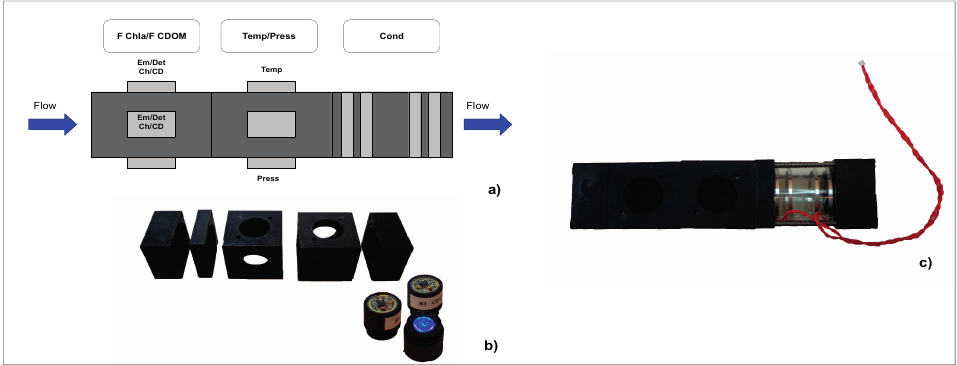
Figure 1. ( a ) Possible combinations of the sensors inside the measurement cell; ( b ) Modules of the measurement cells; ( c ) A prototype of the measurement